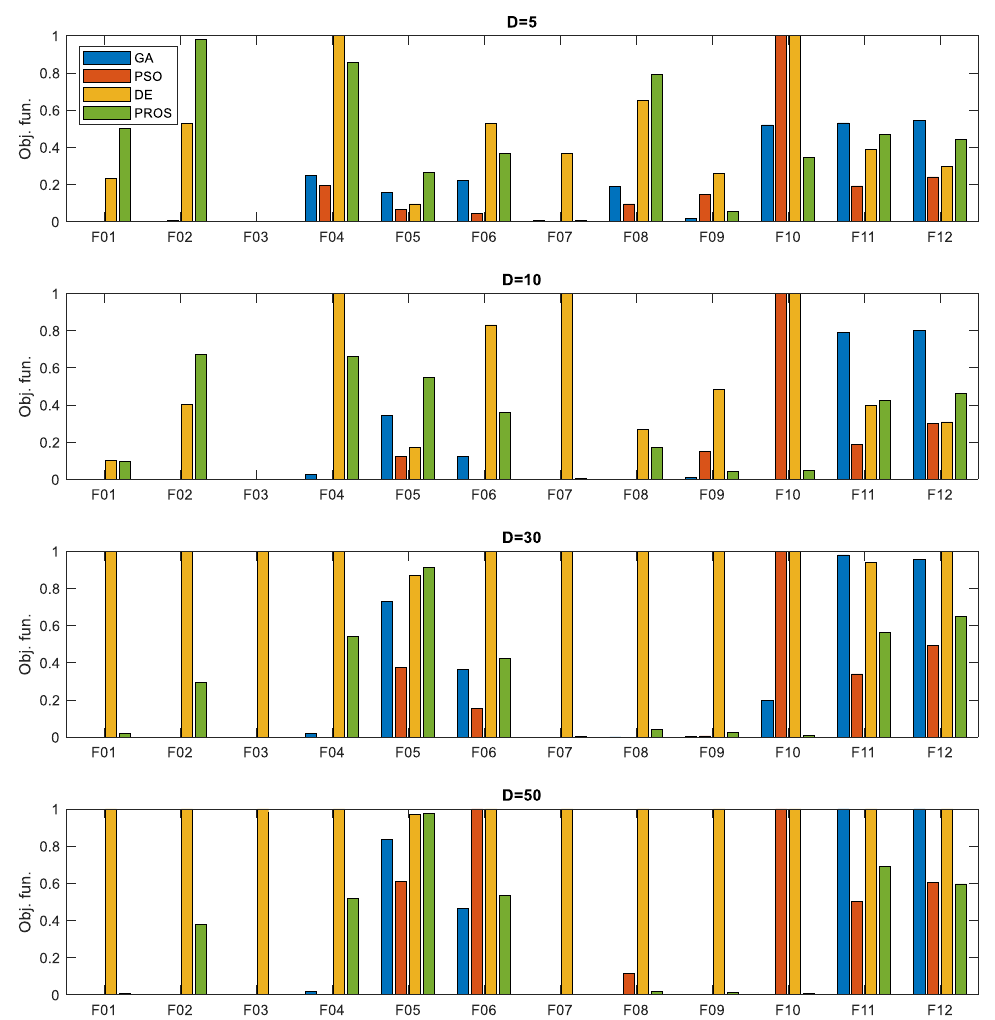
values) for each algorithm, for the different cases (as averages of 10 runs). PRS has been excluded from this comparison because its final objective function values are very large, and it would distort the diagram significantly. For better presentation of the results, the y-axis has been limited to the value of 1 in all cases. Since the target (optimum) value of each of the 12 functions used is zero, the lower bar height is better in this comparison.